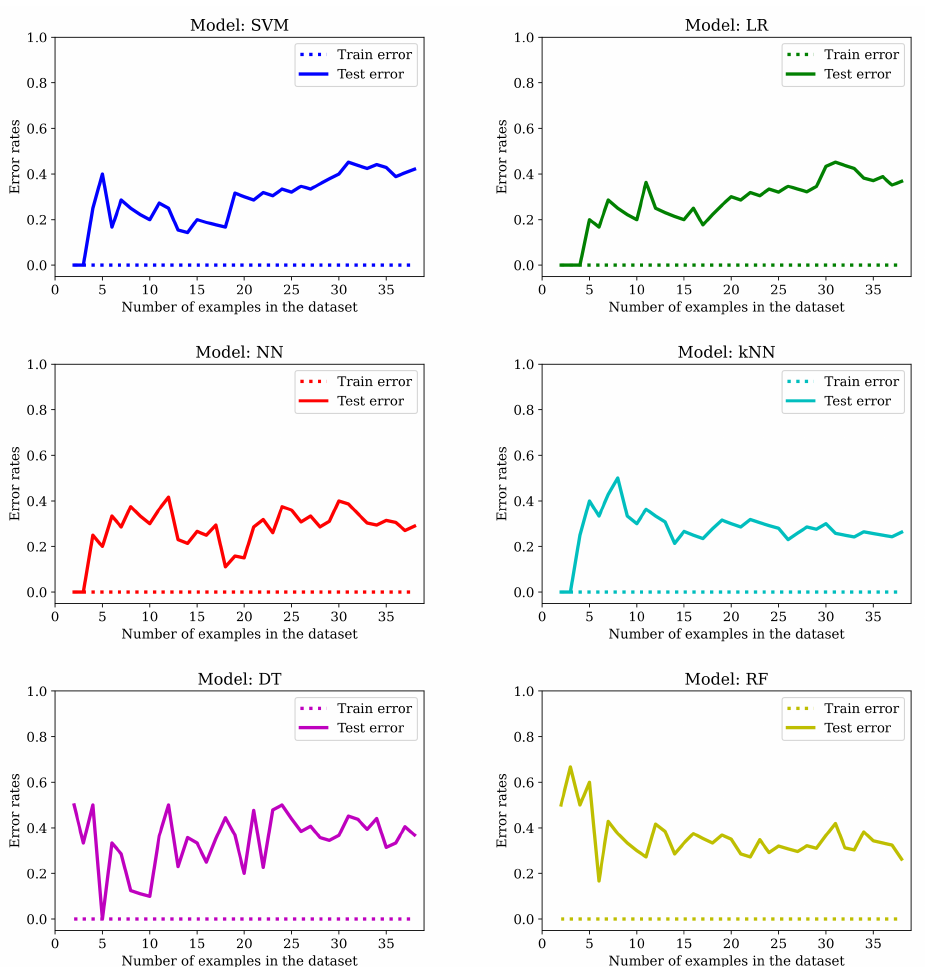
Figure 7. Evolution of error rates with increasing number of examples in training and testing phase for the original data set; the size of the subset of the dataset used for training/testing is represented on the x